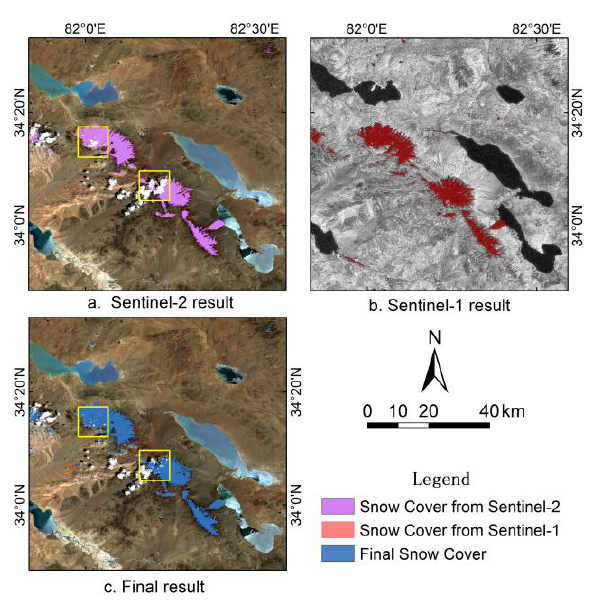
Based on the statistical analysis of the backscattering coefficients and coherence values with the visual interpretation result of the snow cover in the areas without clouds as a